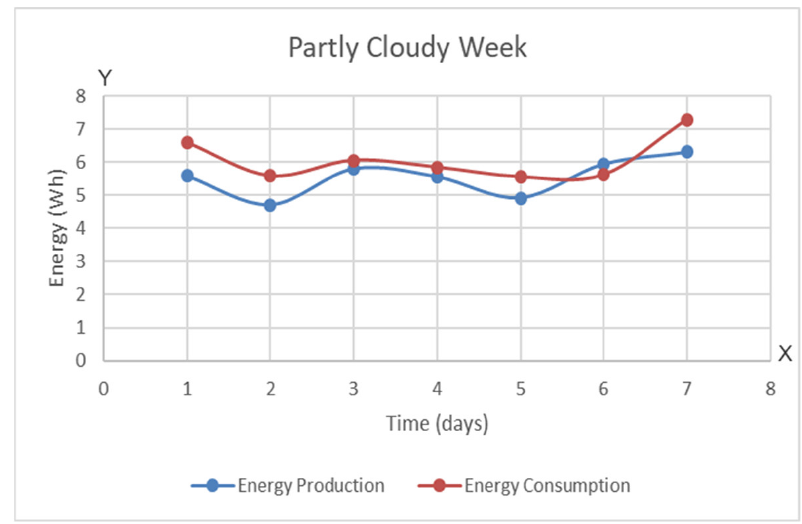
Figure 5. Global Energy Production of the Solar Tracking Device for the Partly Cloudy Week. Figure 5 presents the global energy production in optimum conditions and measured system energy consumption, with the X-Axis representing the number of experimental days and the Y-Axis representing the power generation (blue line) and energy consumption (Wh) (red line) during the partly cloudy week. The equation system solutions (45) show that the average energy production of the solar tracking device is rated at 5.54 Wh, which is outperformed by the system’s energy consumption of 6.07 Wh. It is observable that the relative error rate between the computed E P and the measured power gain is only err = 0.03.